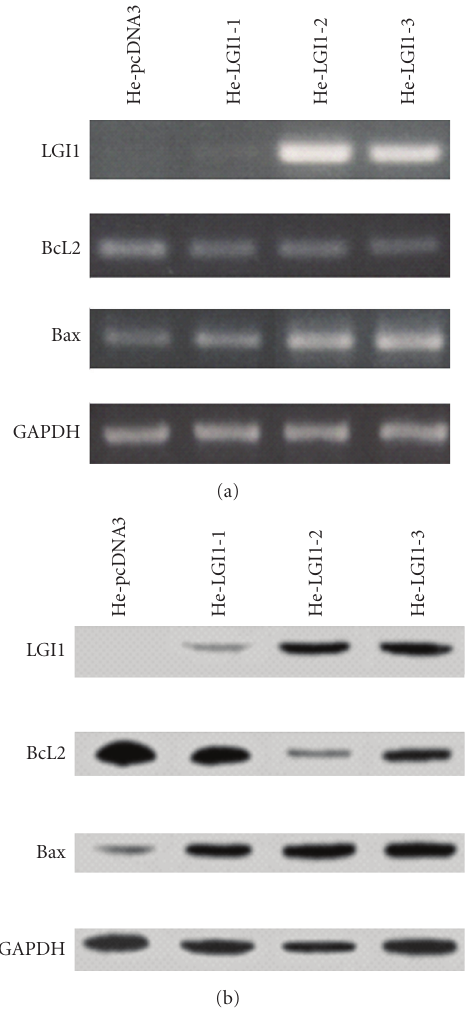
Figure 1: RT-PCR analysis and Western blot. The expression of LGI1, BCL2, BAX, and GAPDH was evaluated in HeLa cell clones expressing LGI1 (HeLGI-1, -2, -3) and control cells transfected with empty vector (He-pcDNA3). The results of RT-PCR analysis are shown in panel (a), those of Western blotting in panel (b).